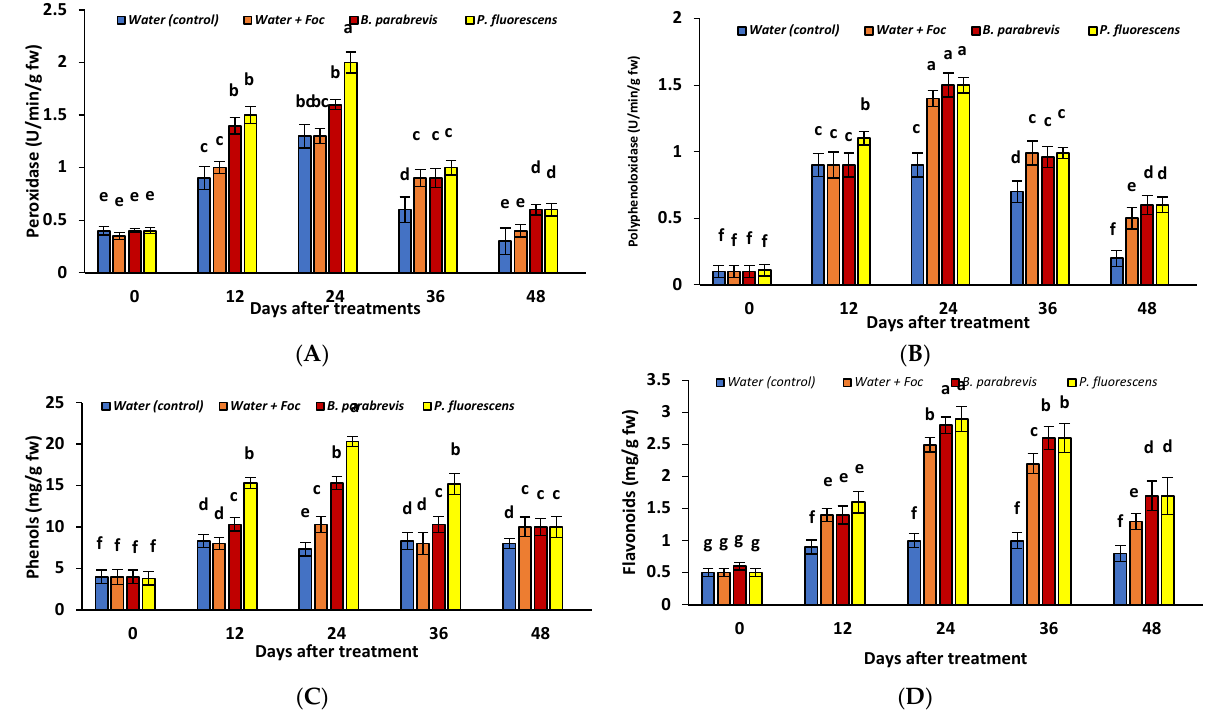
Figure 1. Effect of Brevibacillus parabrevis and Pseudomonas fluorescens on ( A ) peroxidase activity (U/min/g FW), ( B ) polyphenol oxidase activity (U/min/g FW), ( C ) phenol content (phenols (mg/g FW)), and ( D ) flavonoids (mg/g FW) in leaf extracts of cumin plants after inoculated with Fusarium oxysporum . Values in the column followed by different letters were significantly different among treatments according to a least significant difference test ( p = 0.05).